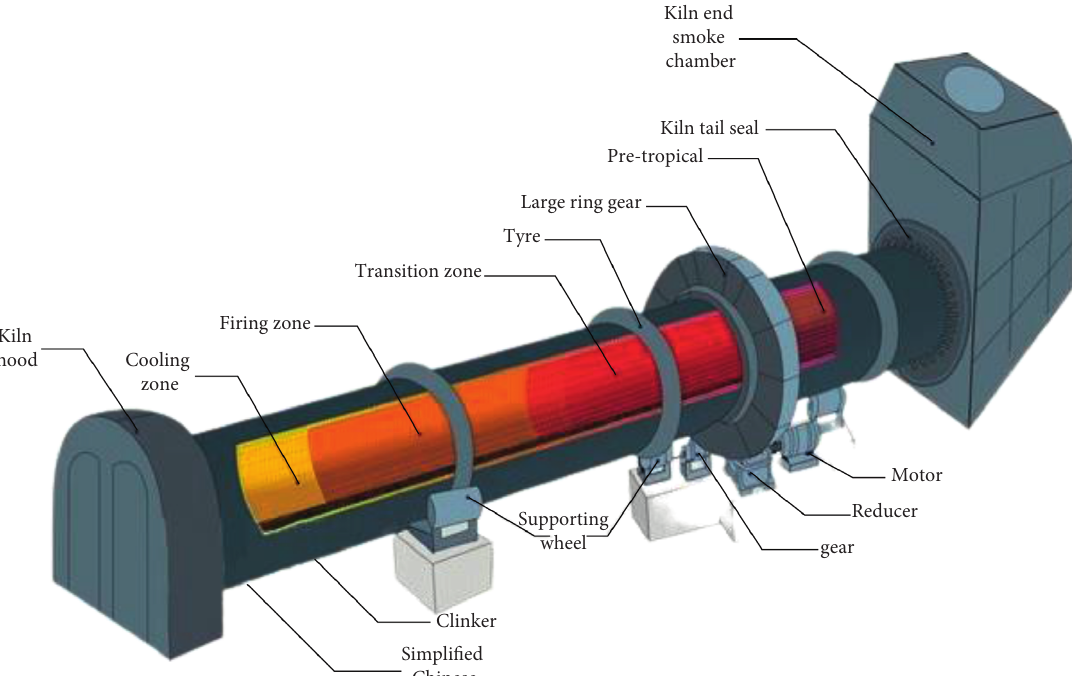
Figure 4: Rotary